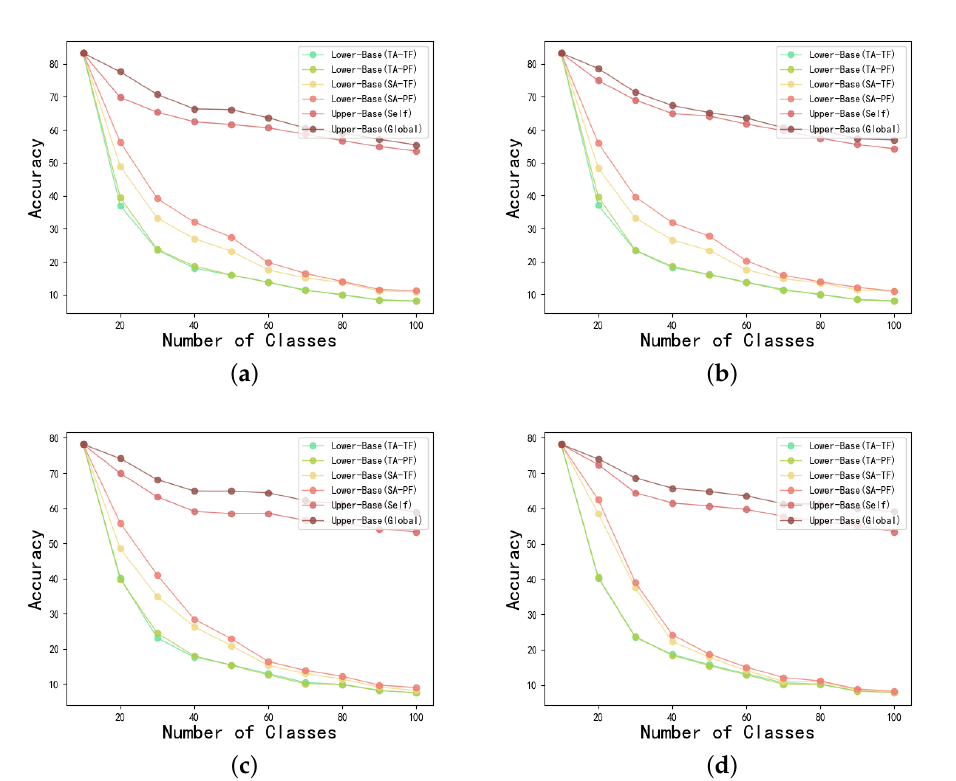
Figure 6. Experimental performance under different combinations. ( a ) CIFAR100: intensive task. ( b ) CIFAR100: sparse task. ( c ) Tiny-ImageNet: intensive task. ( d ) Tiny-ImageNet: sparse